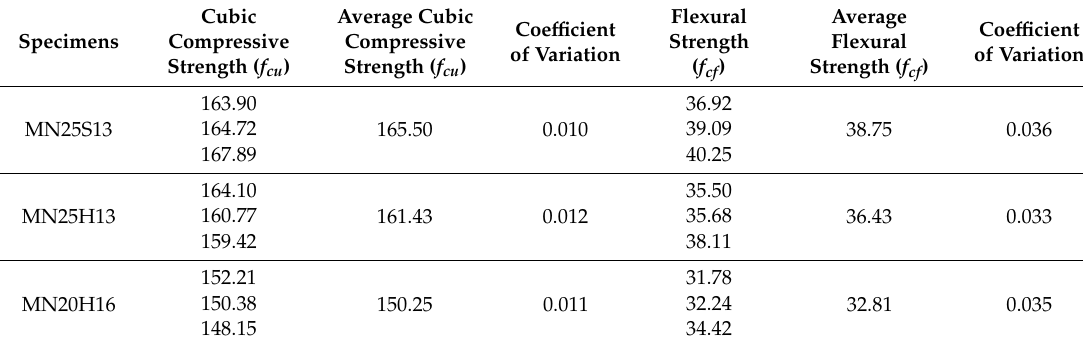
Table 4. Test results of the UHPC materials (unit: MPa).